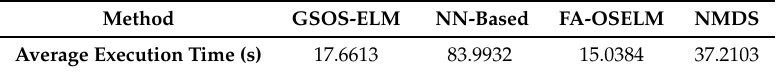
Table 5. Comparison of Average Execution Time under Simulation